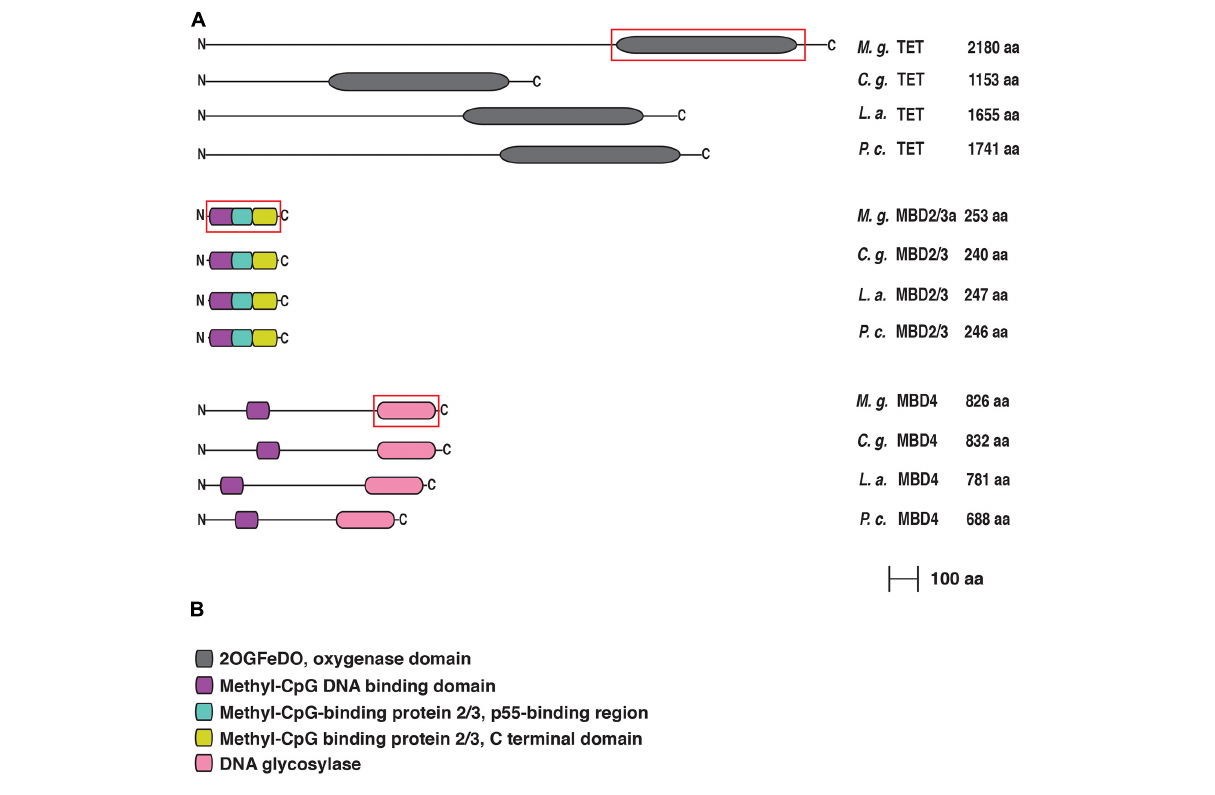
FIGURE 3 | (A) Conserved domain organization of TET, MBD2/3, and MBD4 of Mytilus galloprovincialis in comparison with those of Crassostrea gigas , Lingula anatina , and Pomacea canaliculata . The phylogenetically informative regions used for Bayesian inference are included in a red box. (B) List of the functional domains. For each protein the N-terminus is on the left and the C-terminus is on the